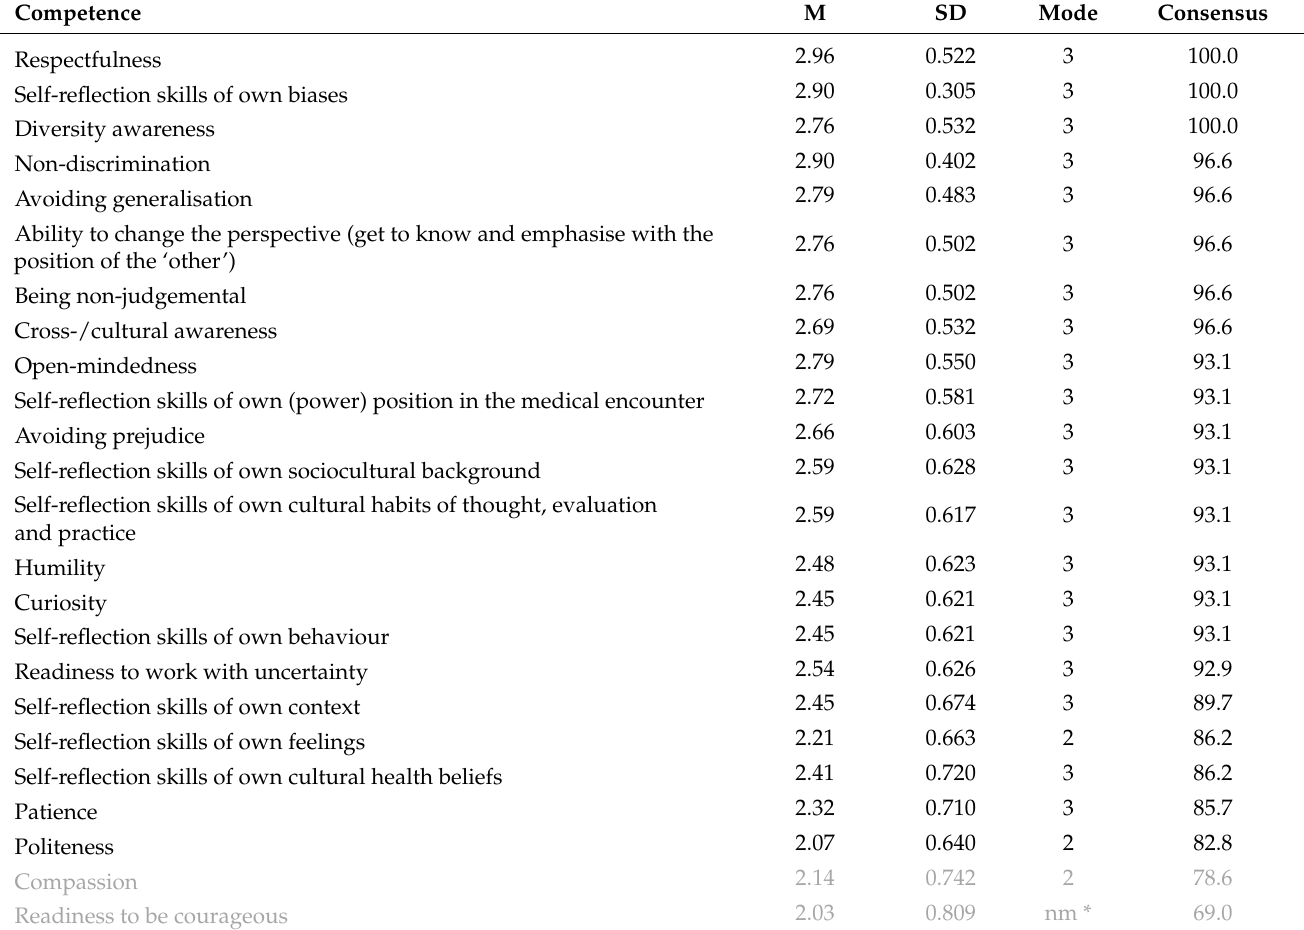
Table 4. Ranking according to consensus in the affective dimension 1